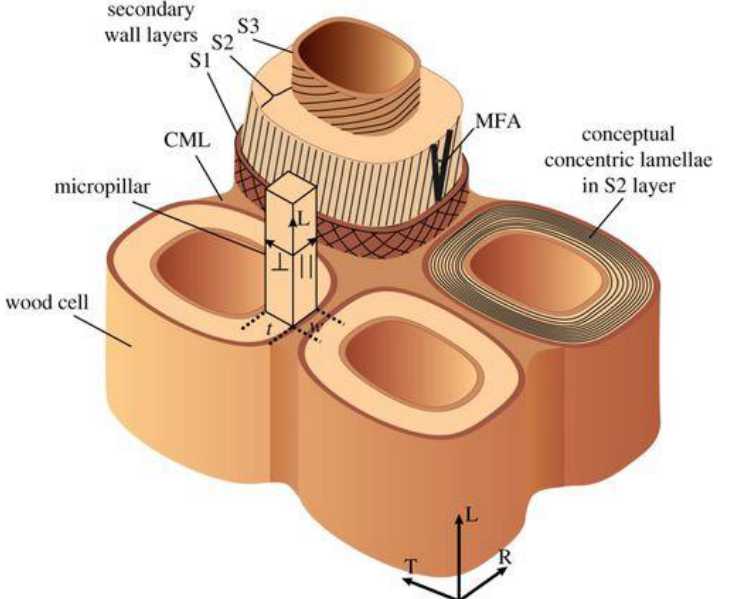
Figure 3. Schematic of cell wall layers within cellular structure of wood. Reprinted from [26] under CC-BY License.